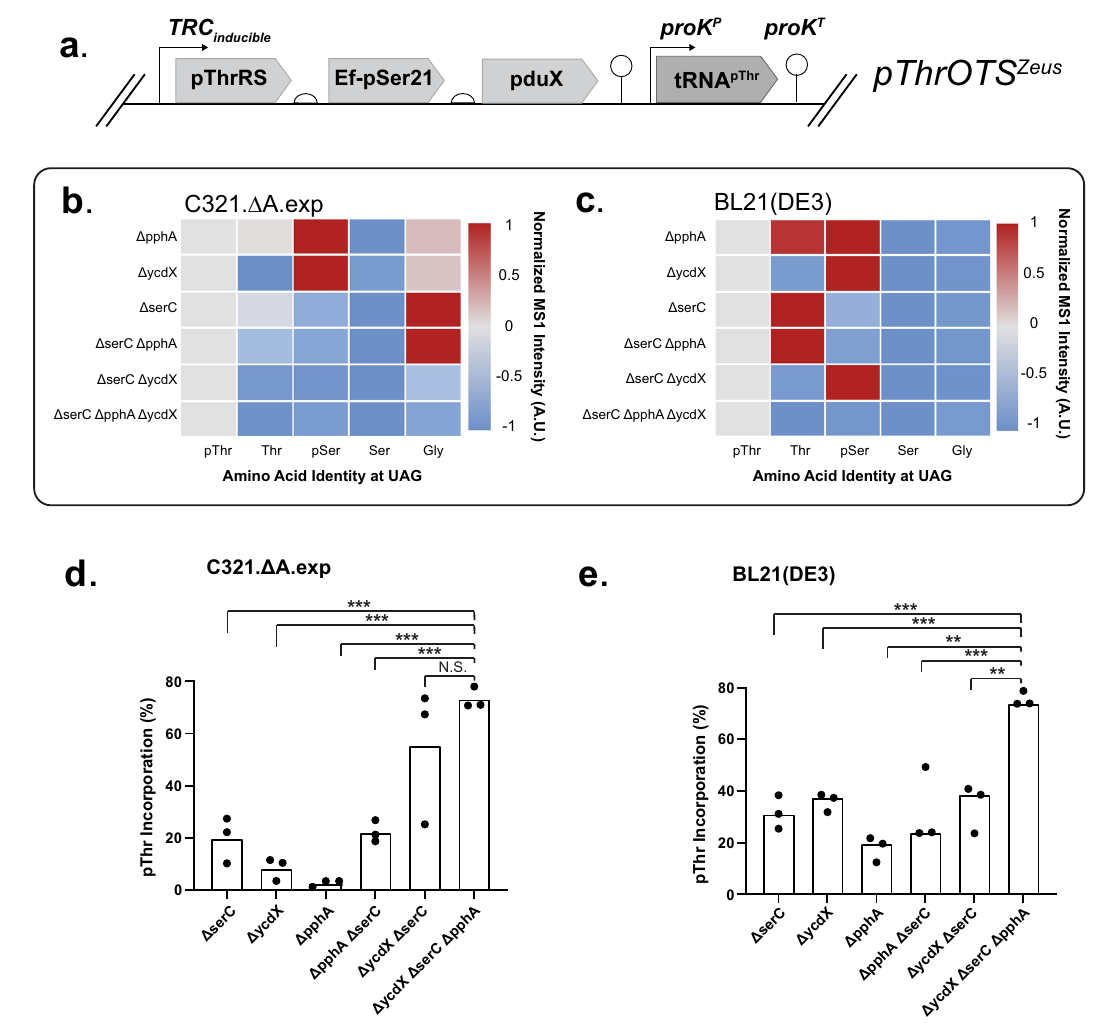
Fig. 1 | Development and characterization of a pThrOTS-strain combination. a SchematicrepresentationofpThrOTS Zeus polycistronicoperonandtRNAcassette. Analysis of MS-READ reporter phosphorylation and expression for b C321. Δ A.exp and c BL21 (DE3). Values are scaled to pThr intensity within strains ( N =3). Percent pThr incorporation ( N =3) for knockout strains expressing pThrOTS Zeus and MS-